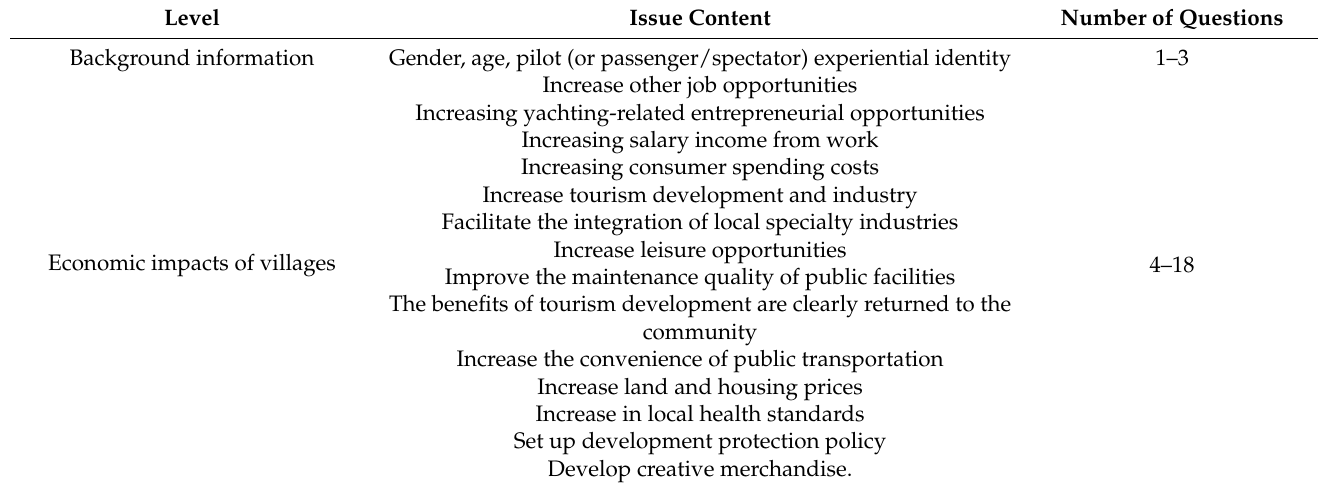
Table 1. Initial questionnaire issue